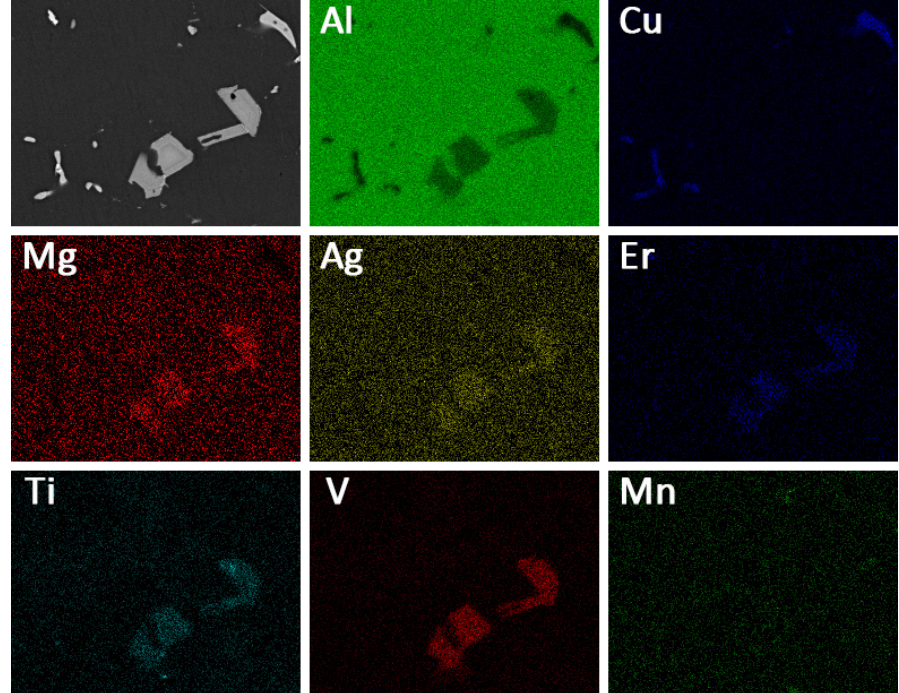
Figure 7. EDS mapping of selected region in Figure 6b.